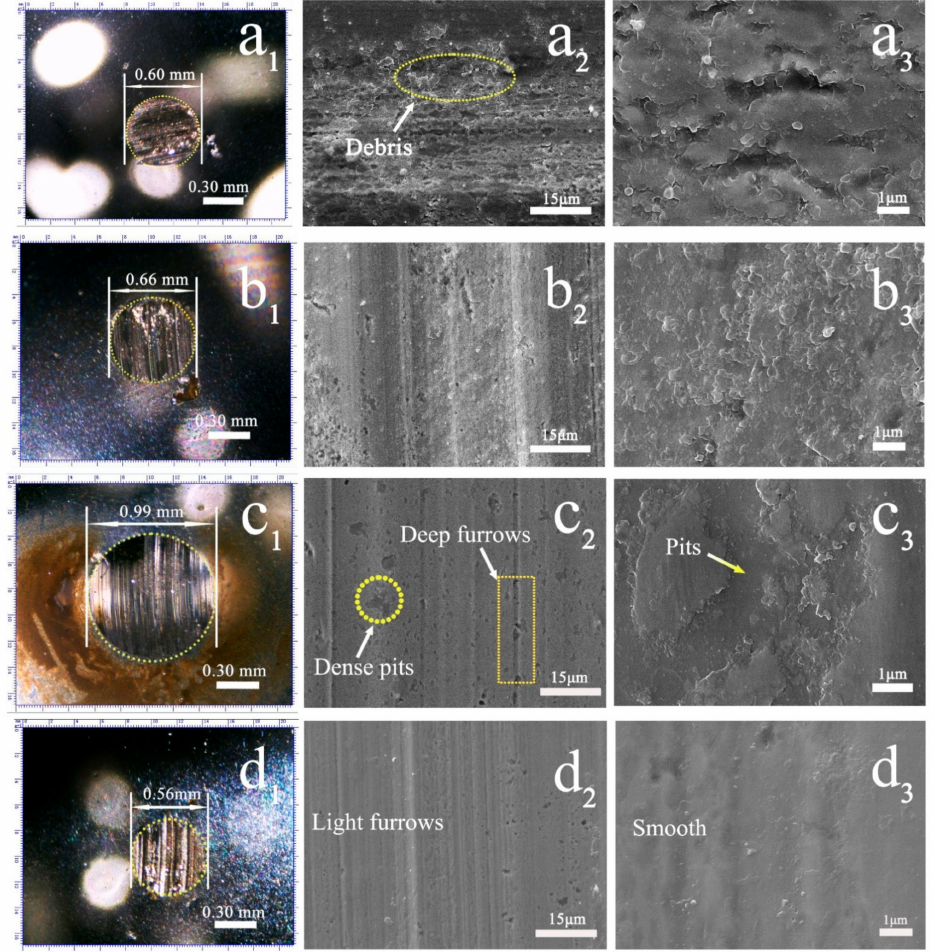
Figure 8. WSD photos and SEM images of the worn samples after tests. ( a ) pristine PAO6 oil at 75 ◦ C, ( b ) 0.25 wt% IF–WS 2 particles at 75 ◦ C, and ( c ) pristine PAO6 oil at 100 ◦ C, ( d ) 0.25 wt% IF–WS 2 particles at 100 ◦